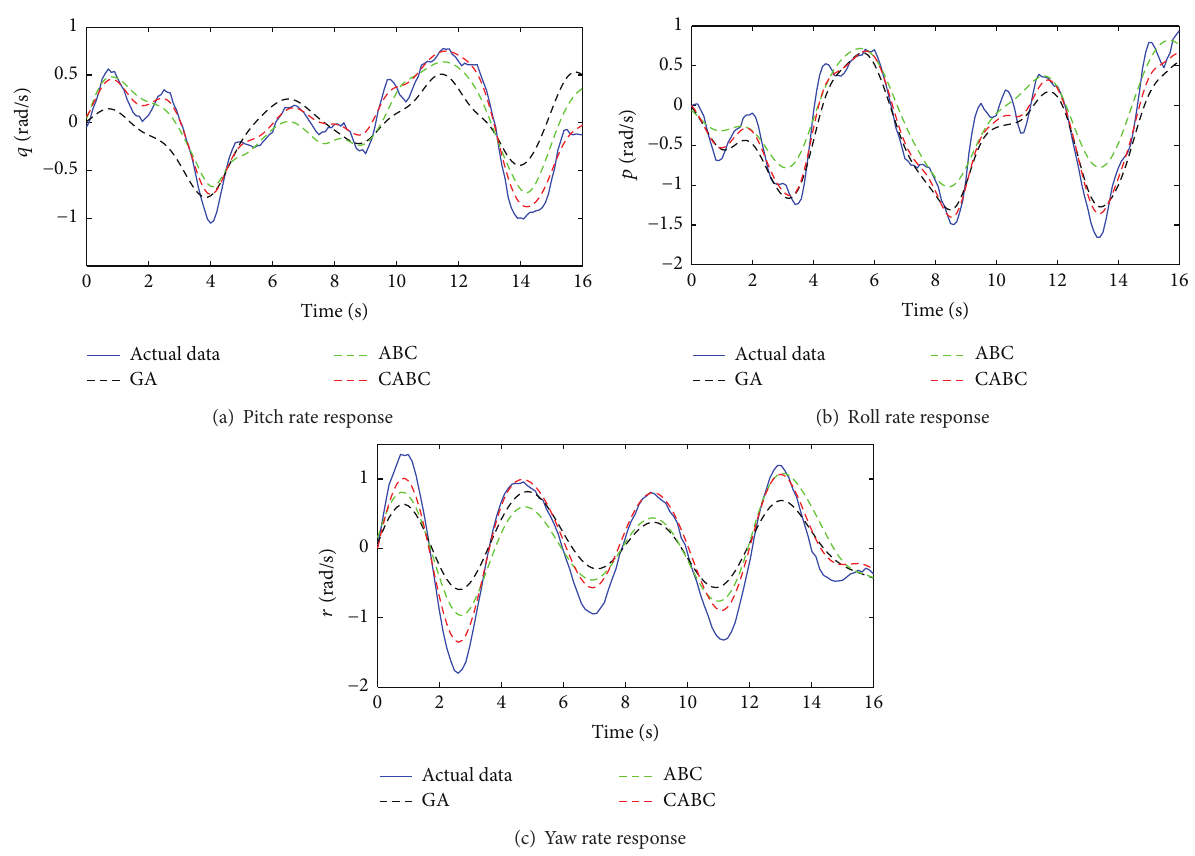
Figure 9: Comparison of the actual and estimated velocities responses.